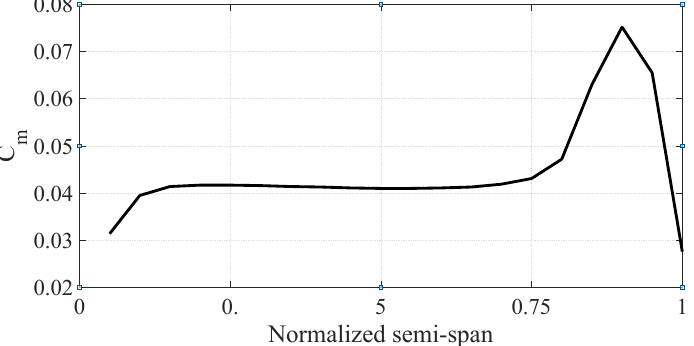
Figure 14. Moment coefficient at the quarter chord along the normalized